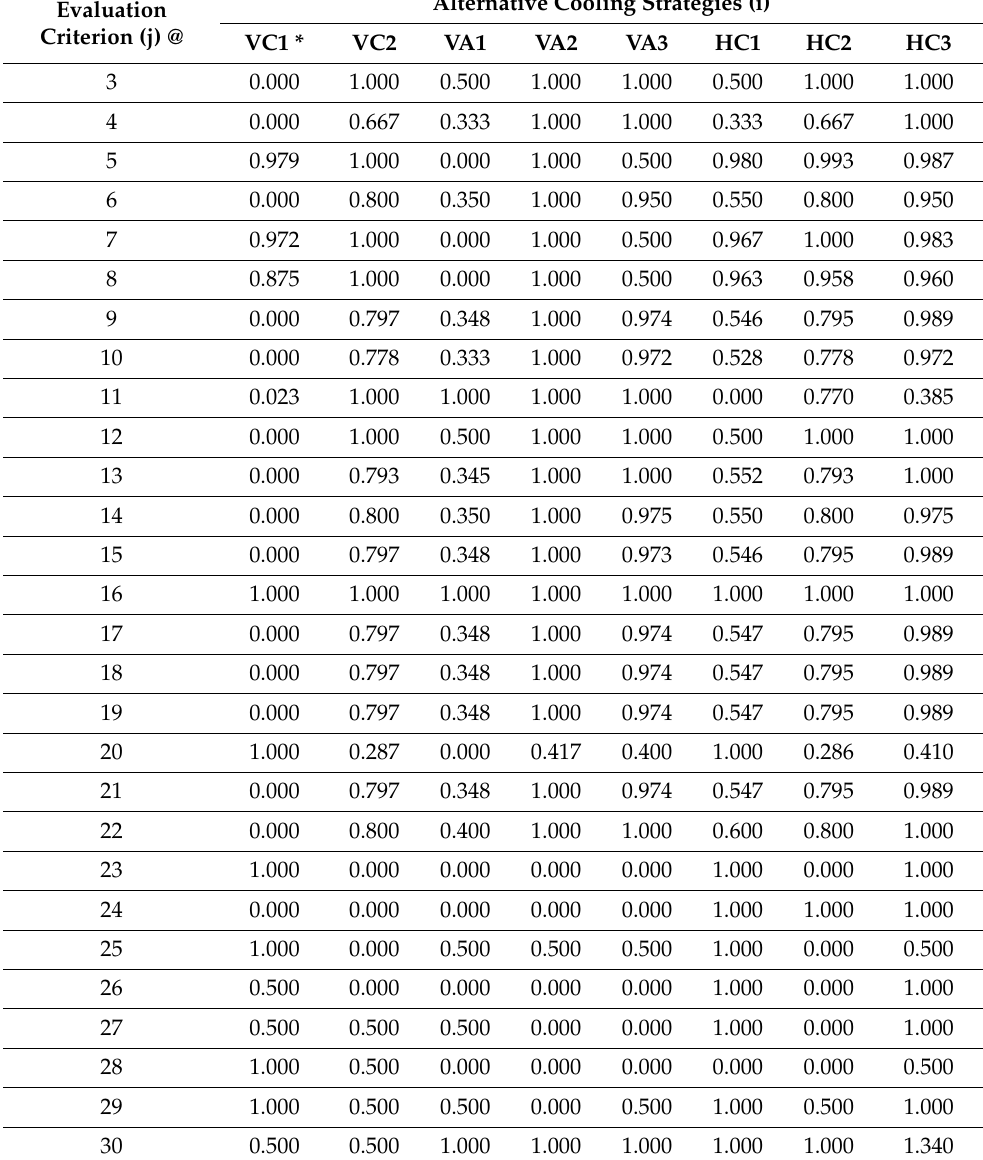
for cooling dry arid climatic zone. ij